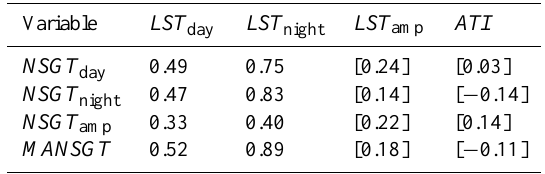
Table 3. Correlation of remotely-sensed variables with in-situ vari- ables at the logger sites. Spearman correlation coefficients and tests, non-significant associations in square brackets; FDR controlled at ≤ 10%.